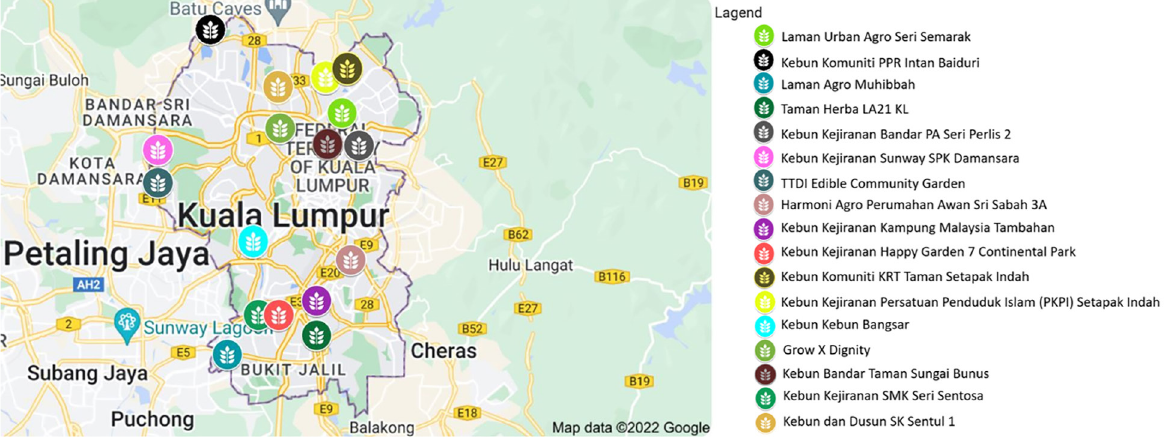
Fig. 1. Map of the locations of all the urban gardens in Kuala Lumpur for the years